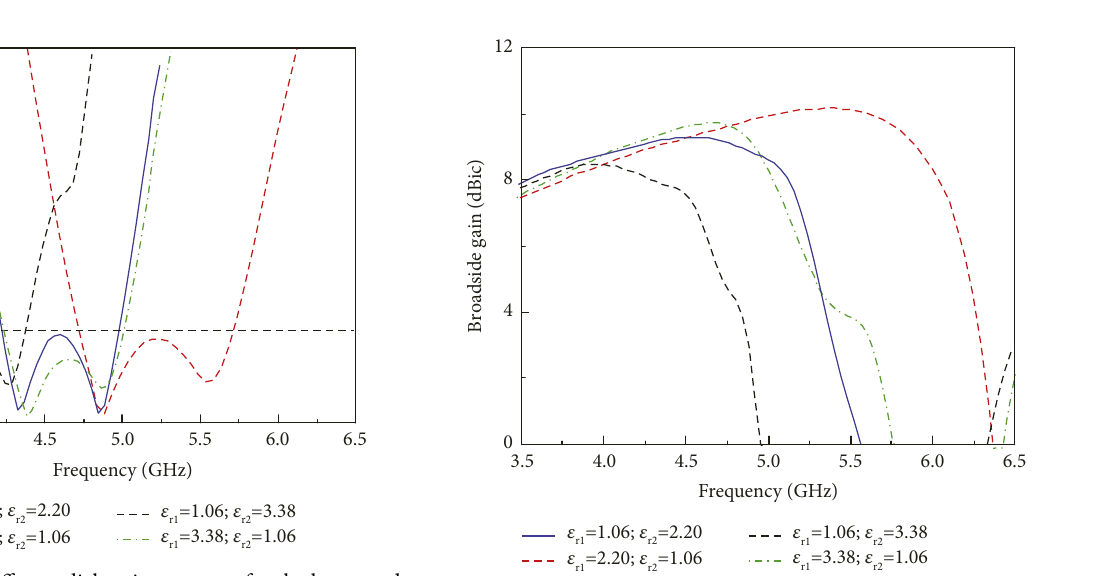
Figure 9: Effects of different dielectric constants for the lower and upper substrates on the broadside gain of the